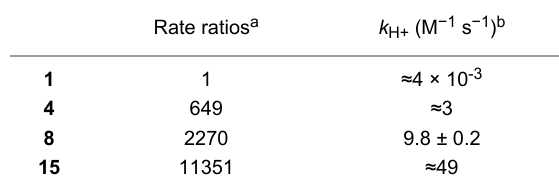
Table 2: The ratio of the rates of hydrolysis for 1 , 4 , 8 and 15